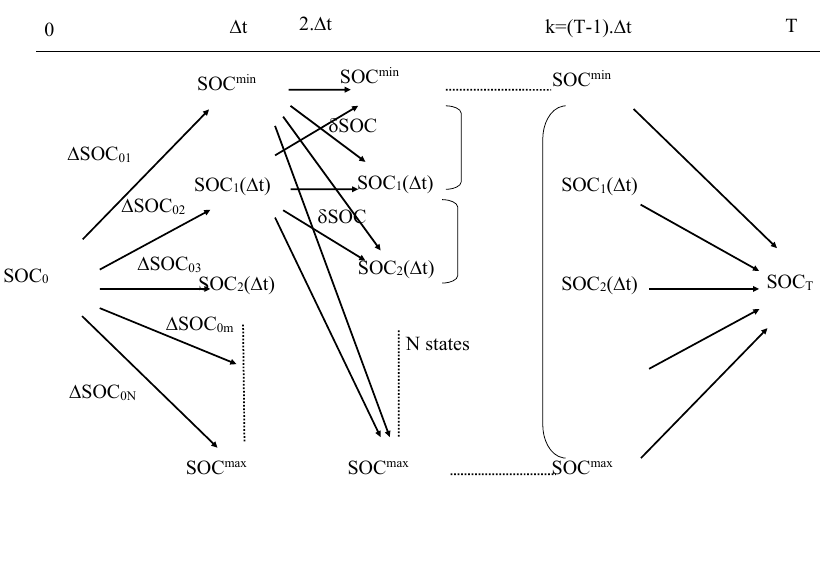
Figure 3. A multi-stage decision procedure with respect to the